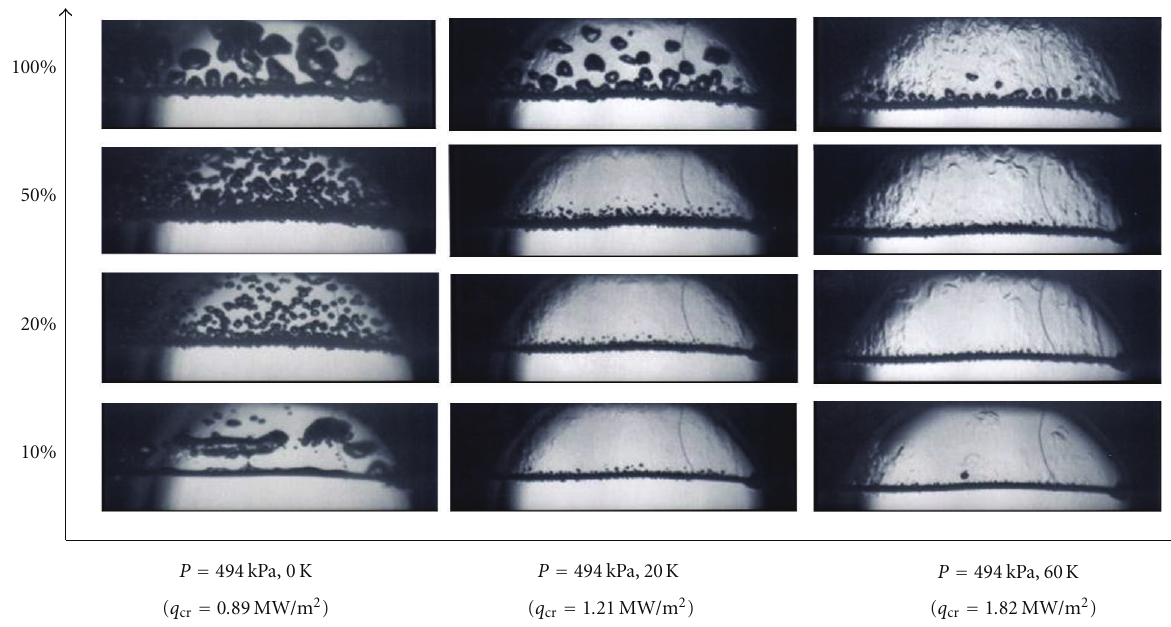
Figure 7: Vapor film behavior during transition to CHF at a pressure of 494 kPa for subcoolings of 0, 20 and 60K in ethanol due to quasi- steadily increasing heat input given by exponential time